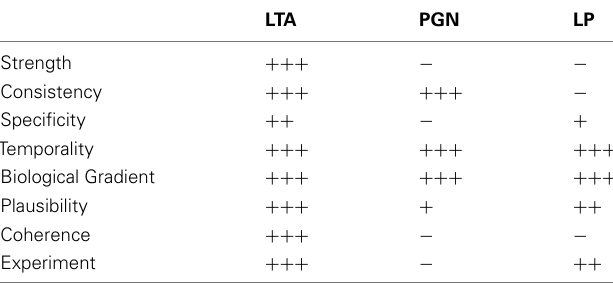
Table 8 | Fulfillment of Bradford Hill criteria for LTA, PGN, and LP (personal weighing of evidence by the authors as explained in the text). LTA PGN LP Strength +++ − − Consistency